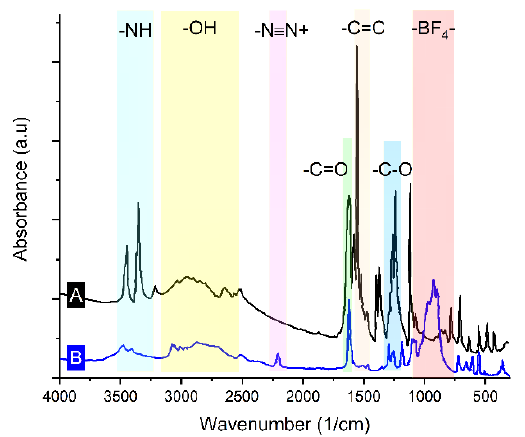
Figure 1. IR spectra of ( A ) 4-carboxybenzenediazonium tetrafluoroborate and ( B ) 4-aminobenzoic acid.